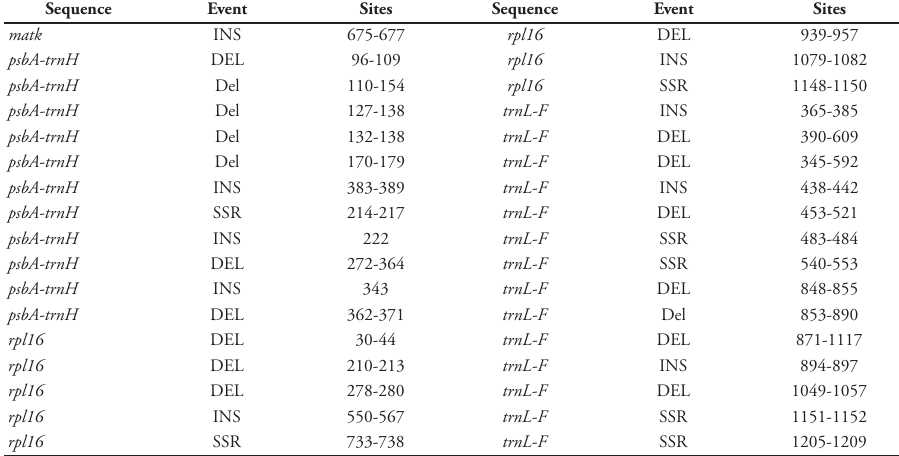
Table A1. Insertion-deletion events coded in the alignment for each sequence. Deletion=DEL, insertion=INS, simple sequence repetition